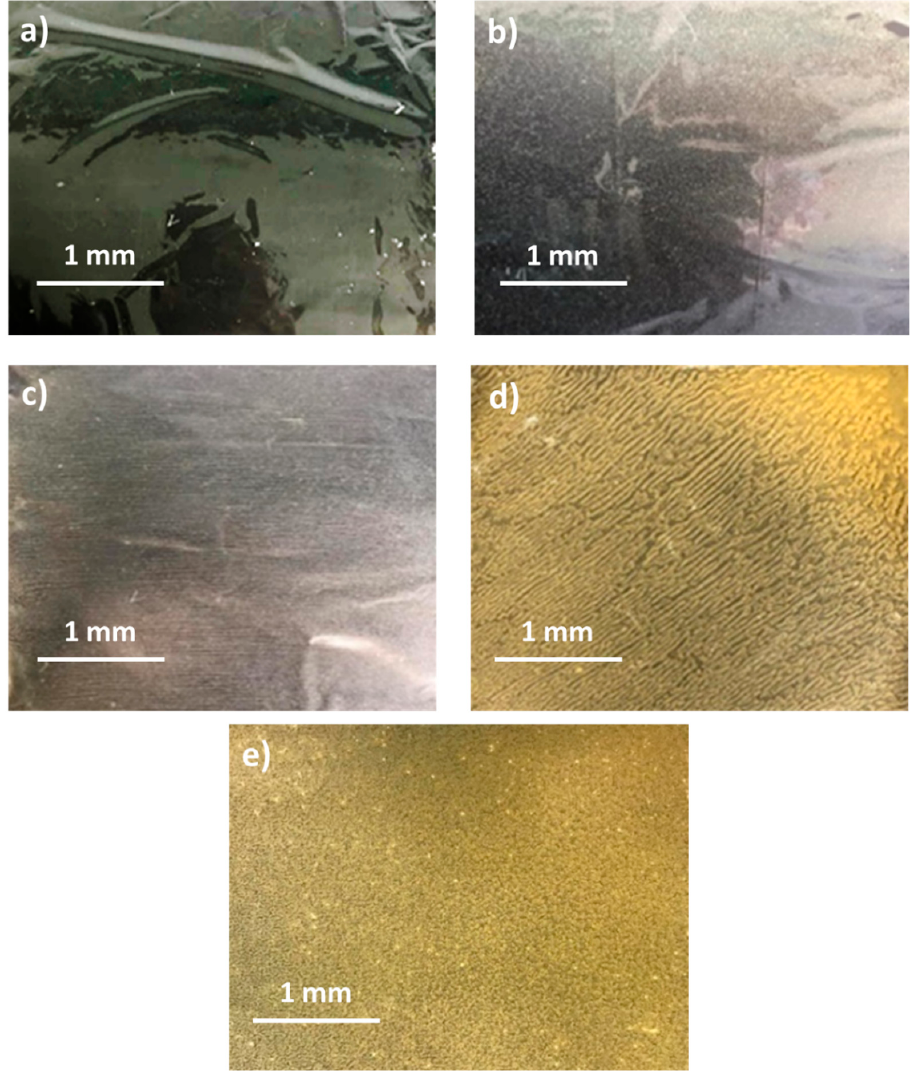
Figure 1. Surface appearance of ( a ) PLA film, ( b ) PLA/10 wt% OPP, ( c ) PLA/20 wt% OPP, ( d ) PLA/40 wt% OPP, and ( e ) PLA/60 wt% OPP composites. wt% OPP, and ( e ) PLA/60 wt% OPP